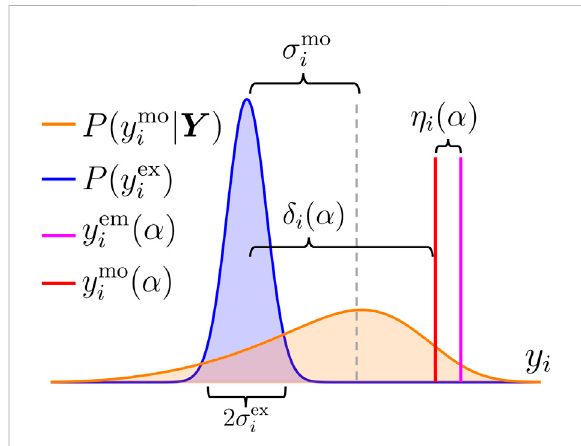
FIGURE 4 Visual representation of the statistical model with the three sourcesofuncertaintyforanobservable y i .Foraparticularvalueof α , the model calculation, y mo i (red vertical line) deviates from the center of the experimental distribution, P ( y ex i ) (blue curve) by the model error δ i ( α ). The size of the experimental error, characterized by σ ex i , is exaggerated in the fi gure to facilitate showing. The estimated value by the emulator, y em i (vertical magenta line) deviates from the model calculation, y mo i , by the emulator error, η i ( α ). The model error scale, σ mo i , characterizes the expected size of δ i ( α ) as the parameters α are varied within their meaningful physical range. This parameter range is characterized by the Bayesian posterior distribution P ( y mo i | Y ) (orange curve), -obtained only after the analysis is done-of the observable y i given all the calibration data Y